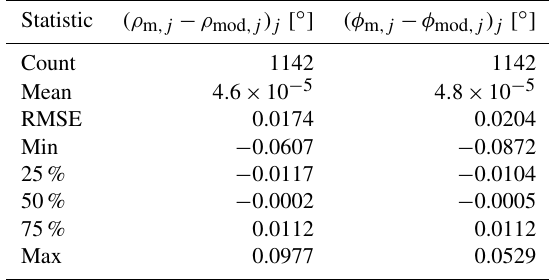
Table 2. Error statistics of the modelled roll and pitch angles to the measured roll and pitch